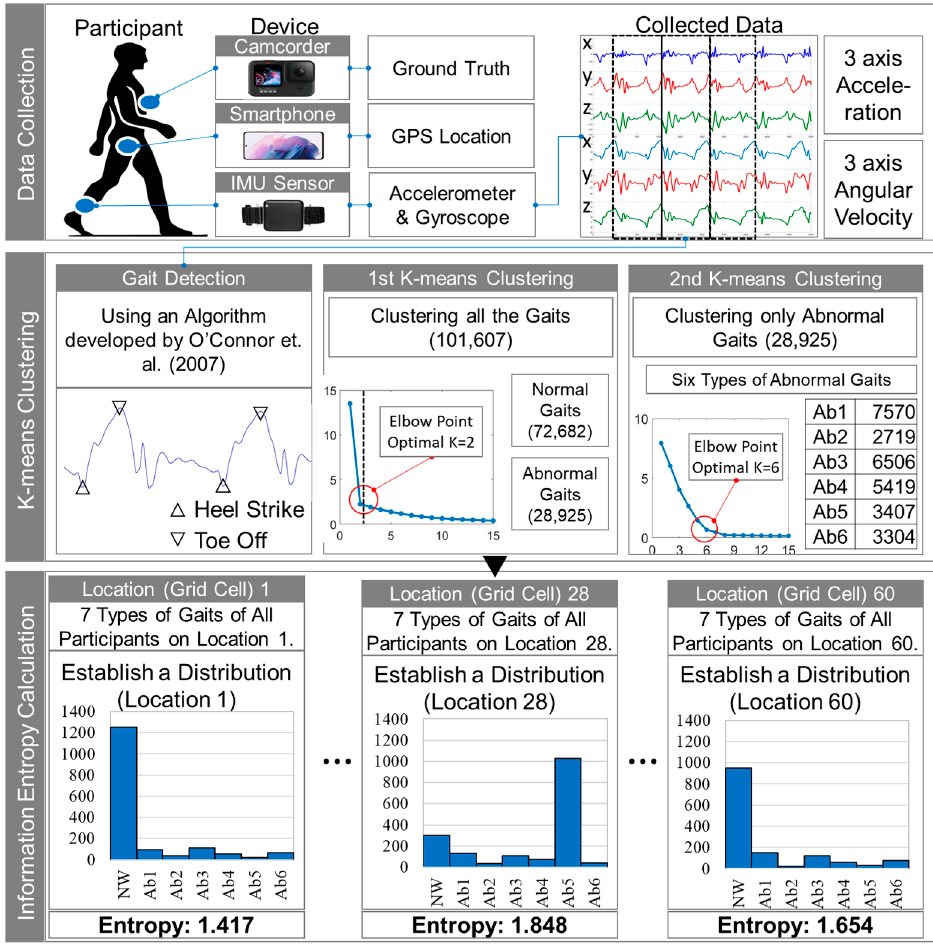
Figure 2. Research framework.